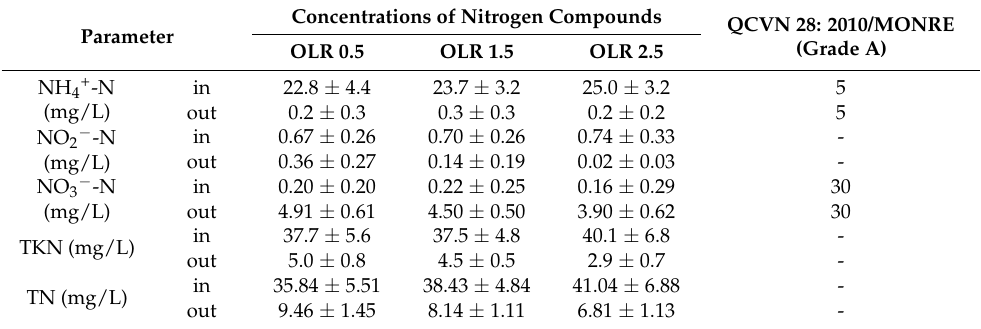
Table 2. Concentrations of nitrogen compounds in hospital wastewater after treatment in various organic load rates.